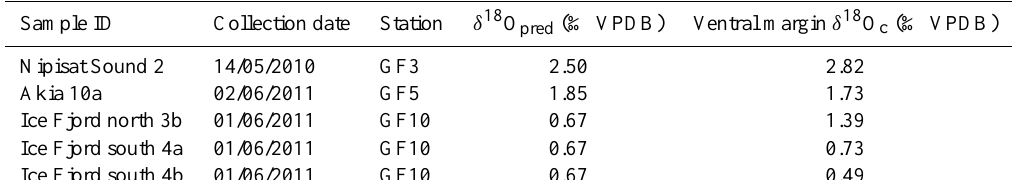
Table 3. Comparison of ventral margin δ 18 O c and δ 18 O pred values.